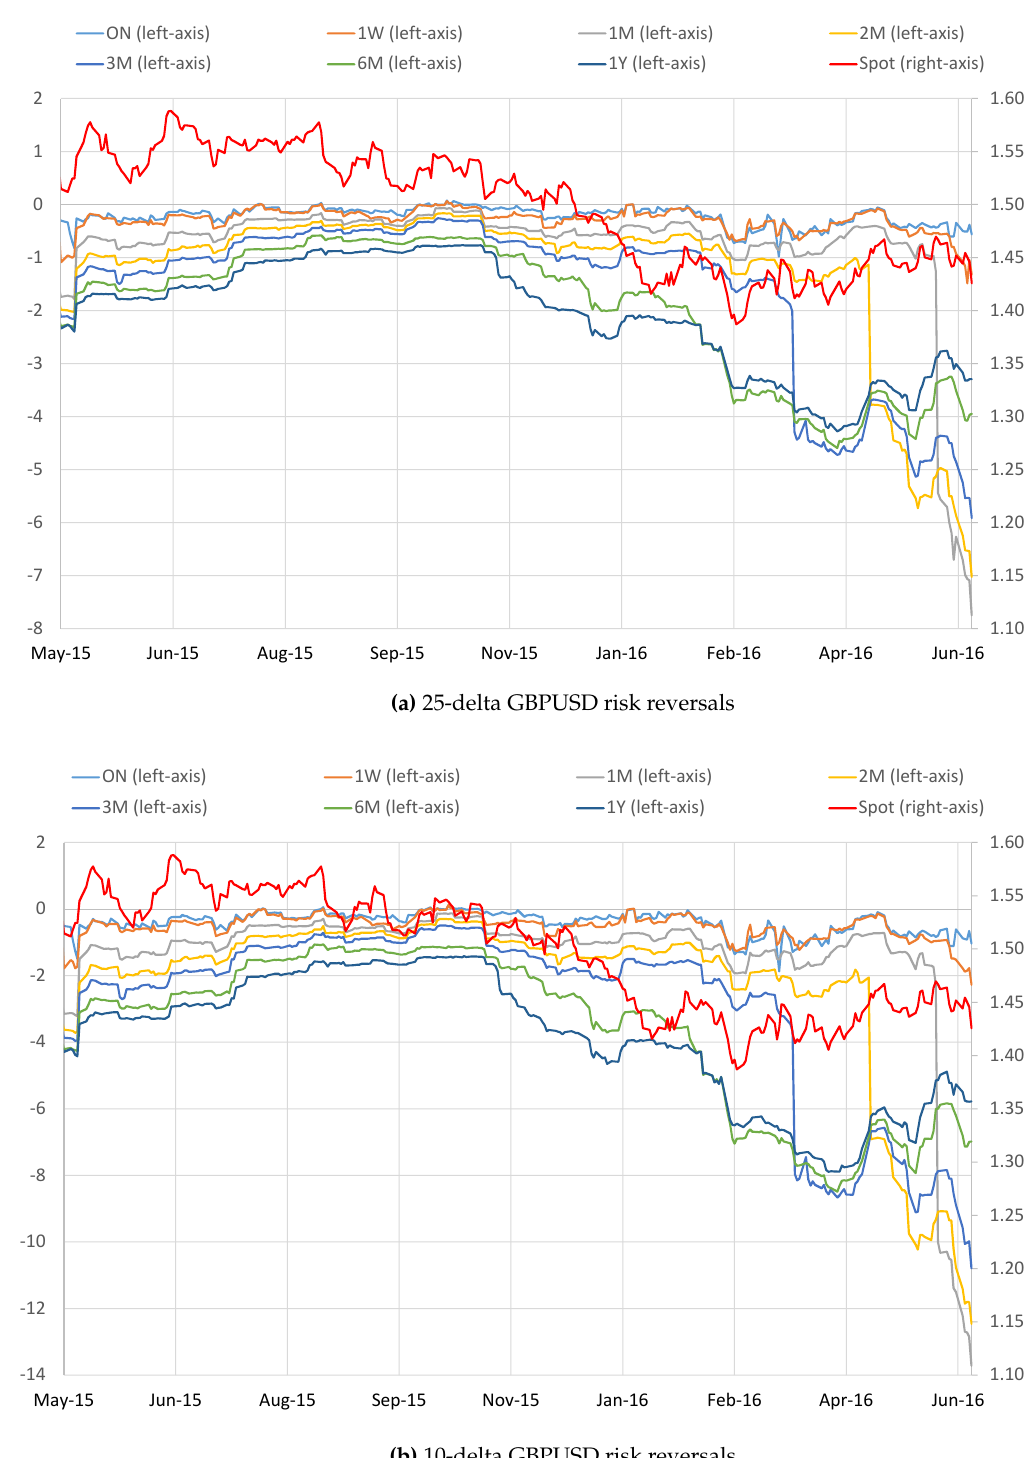
Figure 2. GBPUSD risk reversals, for expiries from overnight [ON] through to one year [1Y], vs. GBPUSD FX spot rates (1 May 2015 to 1 June